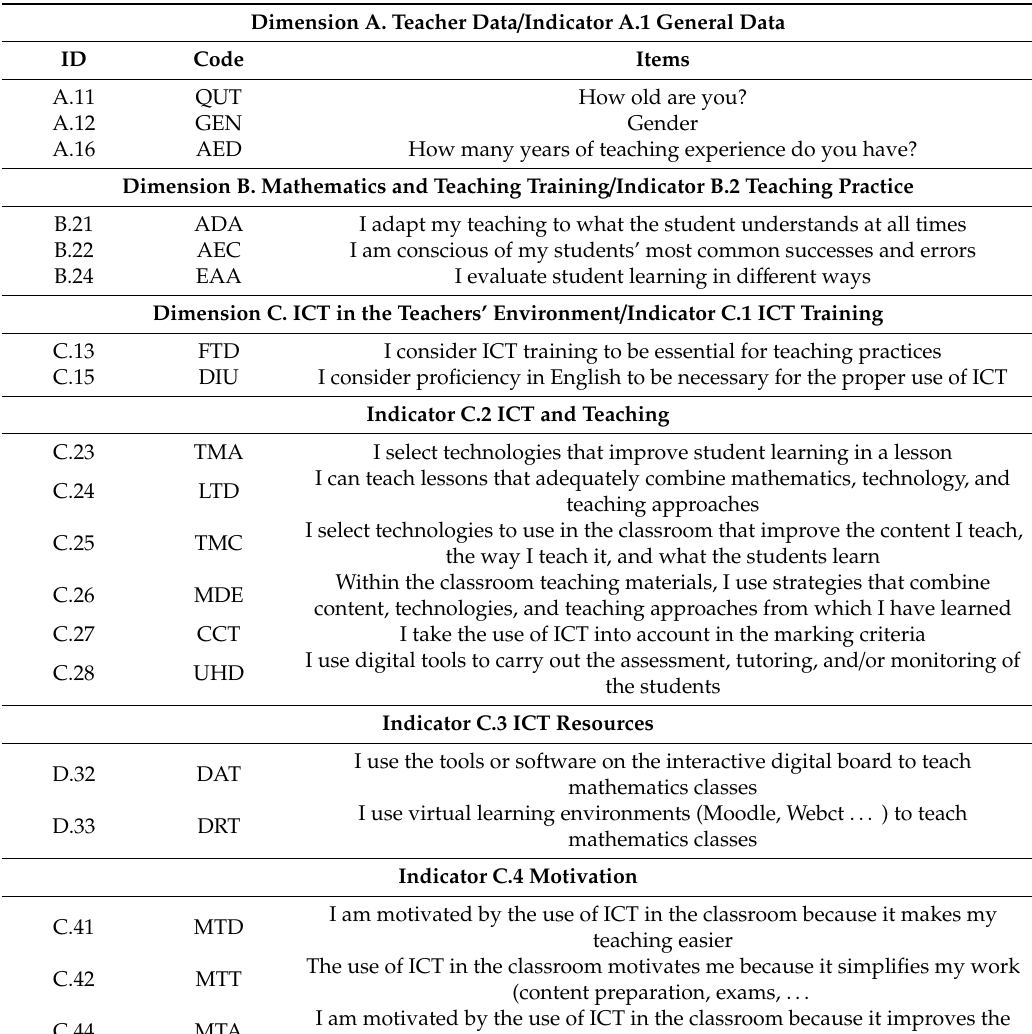
Table 1. Relationship between items, indicators, dimensions, and codes used in the